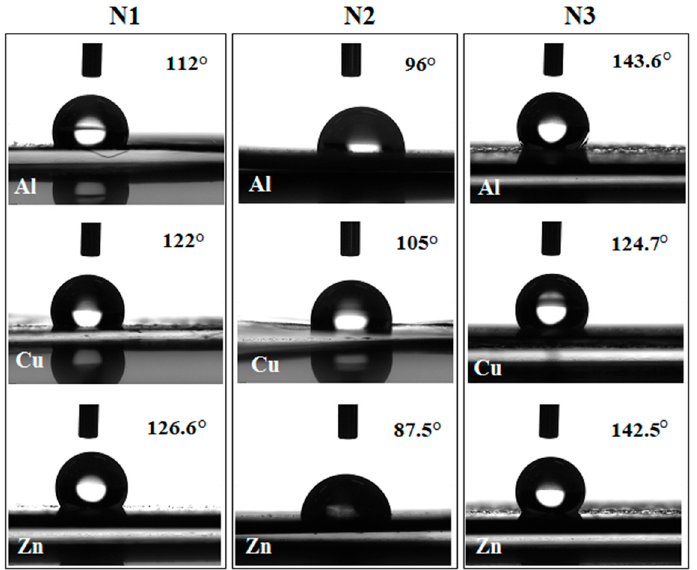
Figure 4. Values of water contact angles and profiles of water drop on metallic surfaces (Al, Cu, Zn) coated with sol-gel modified materials: N1 (ZnO-TEOS/OTES), N2 (ZnO-TEOS/GPTMS), N3 (ZnO-TEOS/ODTES).